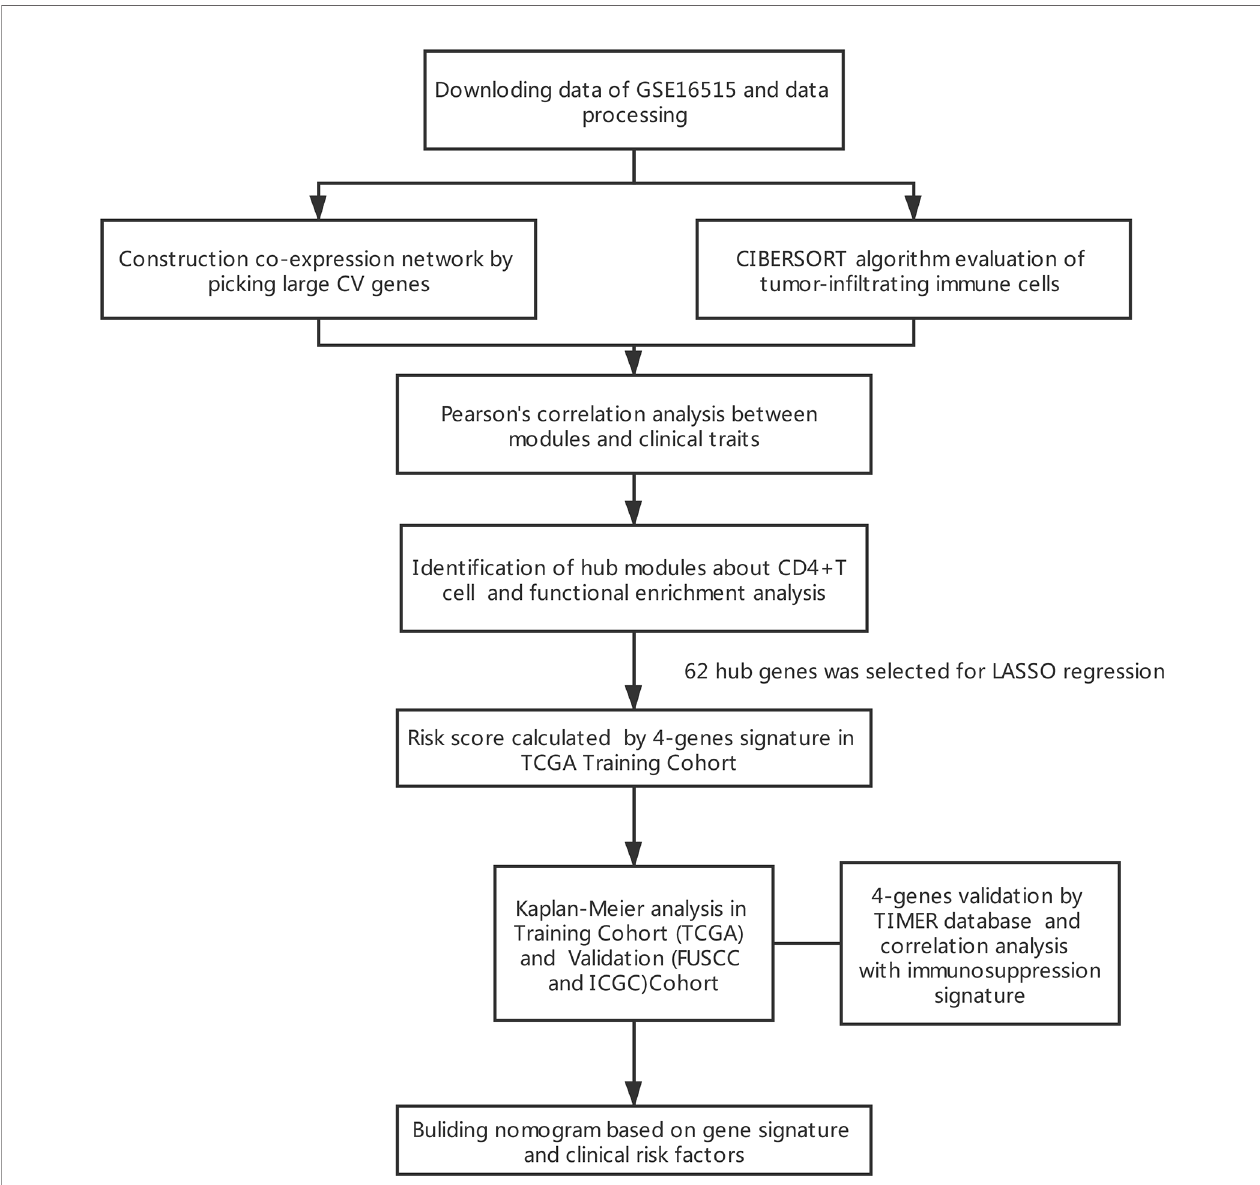
FIGURE 1 | Flowchart presenting the process of establishing the gene signature in this